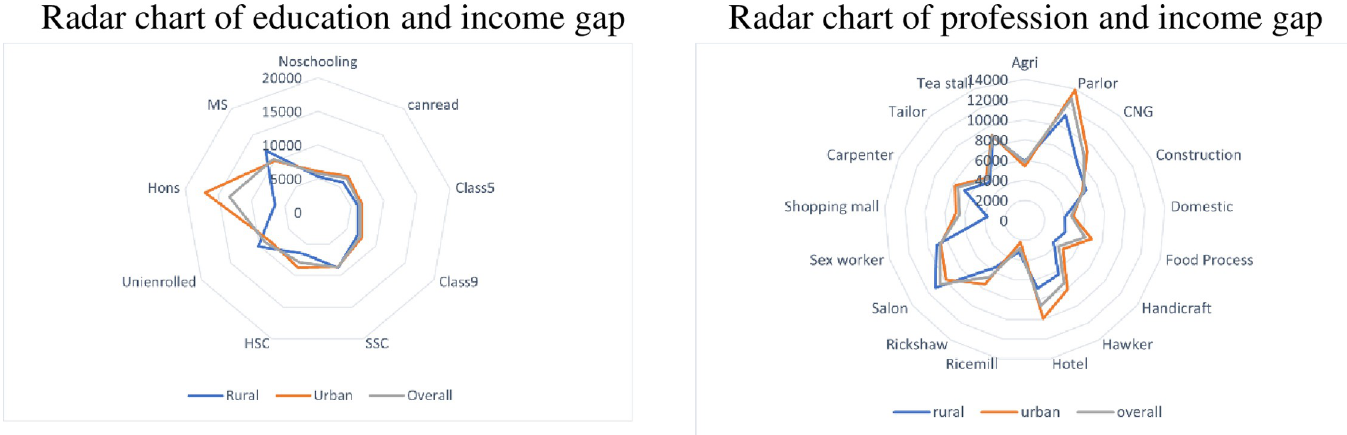
Fig 3. Radar charts of education and profession with the income